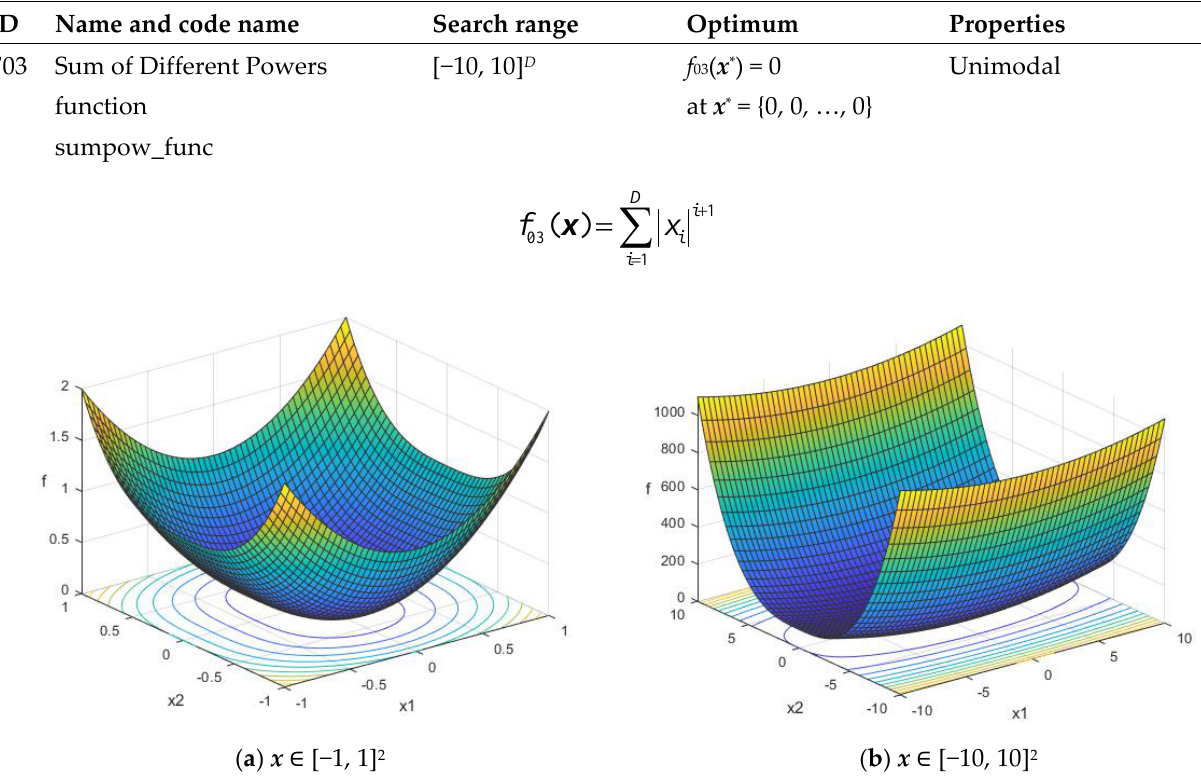
Figure A3. Sum of different powers function in two dimensions.